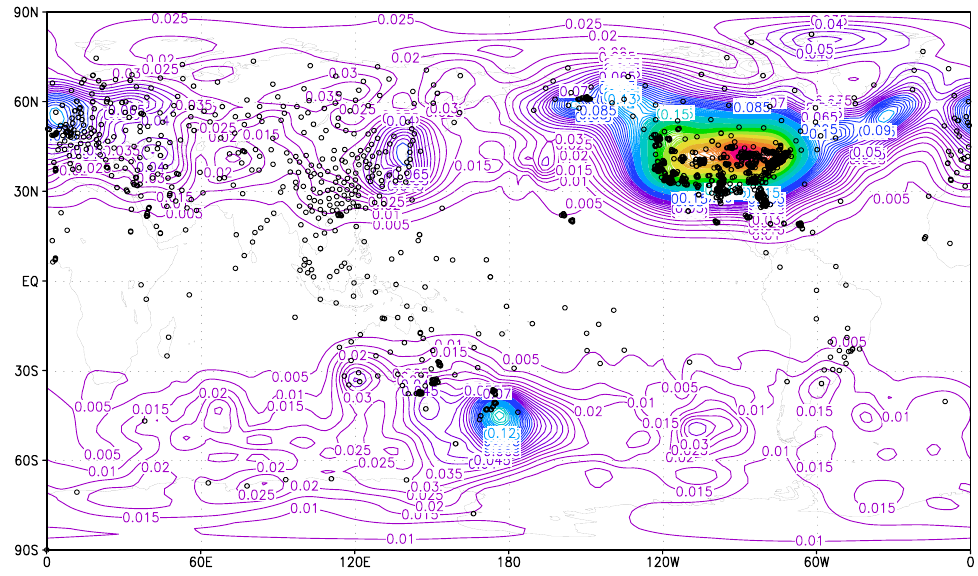
Fig. 9. Circles represent the locations of temperature observations between 500mb − 50mb and 500mb + 50mb, and contour lines represent the OIS for temperature at 500mb.